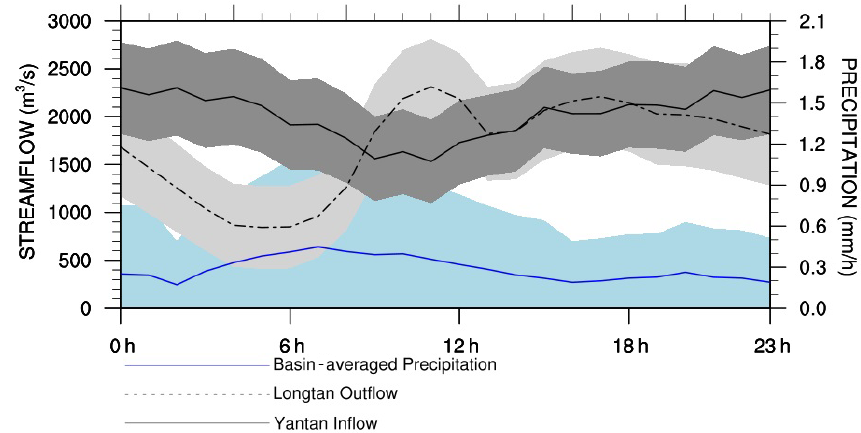
Figure 8. Diurnal cycle of Longtan outflow (m 3 /s; dashed black line), Yantan inflow (m 3 /s; solid black line) and basin-averaged precipitation (mm/h; blue line) as well as their ranges. The time shown in this figure is universal